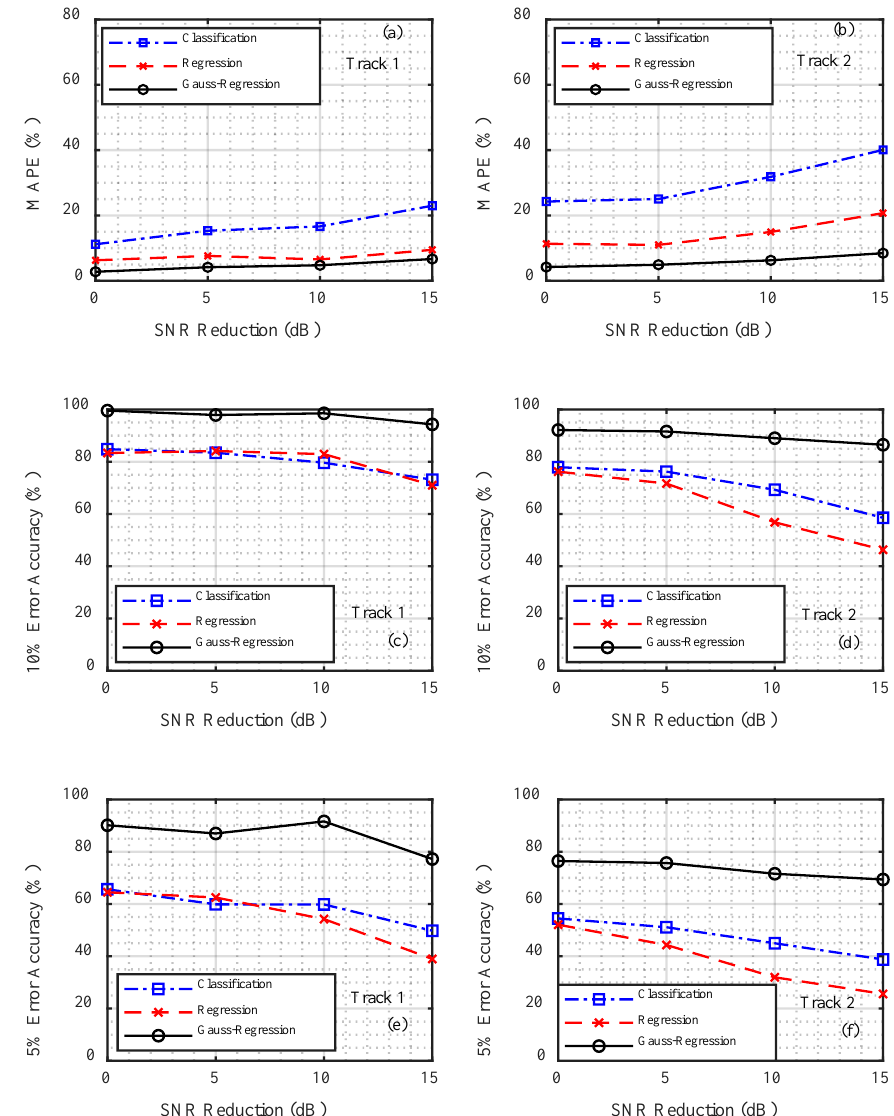
Figure 8. Comparison of the track 1 and track 2 data ranging results for the different convolutional neural networks. ( a , b ) Mean absolute percentage error (MAPE), ( c , d ) probability of credible localization (PCL) −10%, and ( e , f ) PCL −5%.